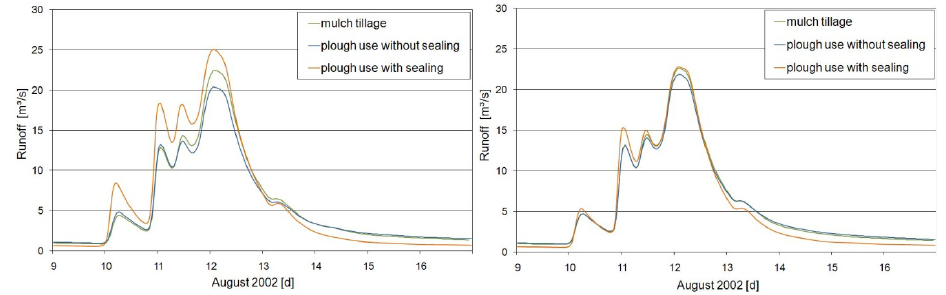
Figure 6: Windach catchment (northern part, A E = 68 km²), HQ 10 , Land‐use scenario: 95 % 2 Fig. 6. Windach catchment (northern part, A E =68km 2 ), HQ 10 , Land-use scenario: 95% cropland, left: consideration of bulk density, right: cropland, left: consideration of bulk density, right: no consideration bulk density 3 no consideration bulk density.